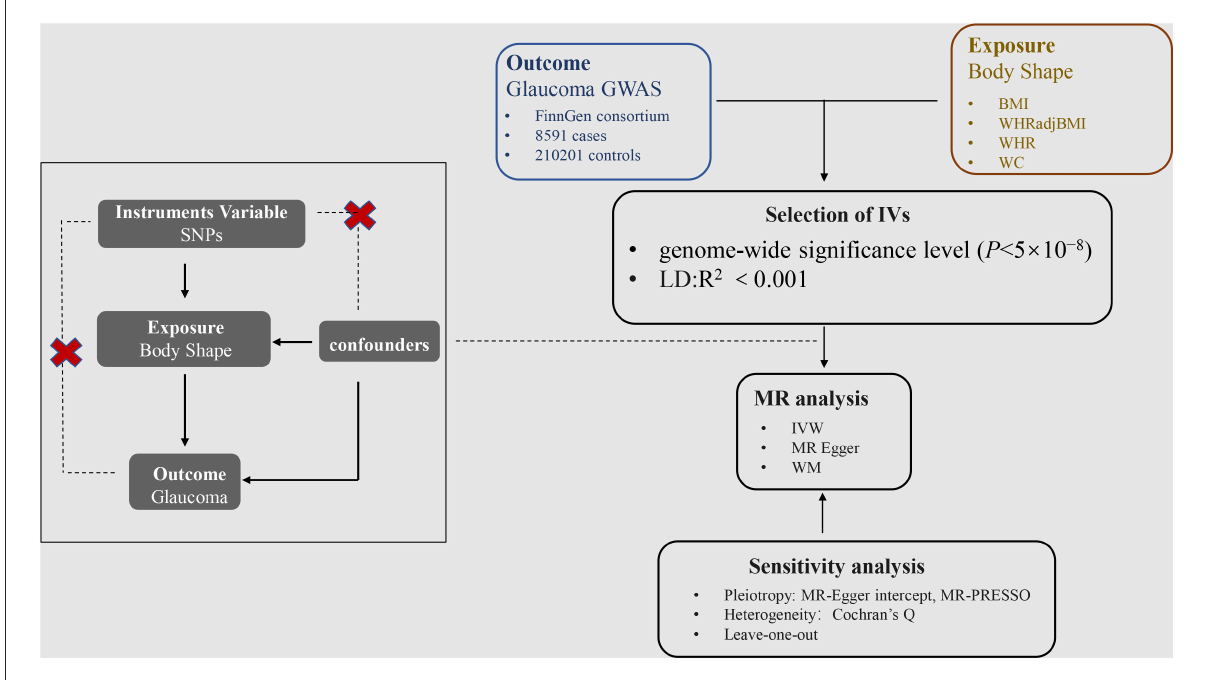
FIGURE1 Acyclic graph interpretation of Mendelian randomization